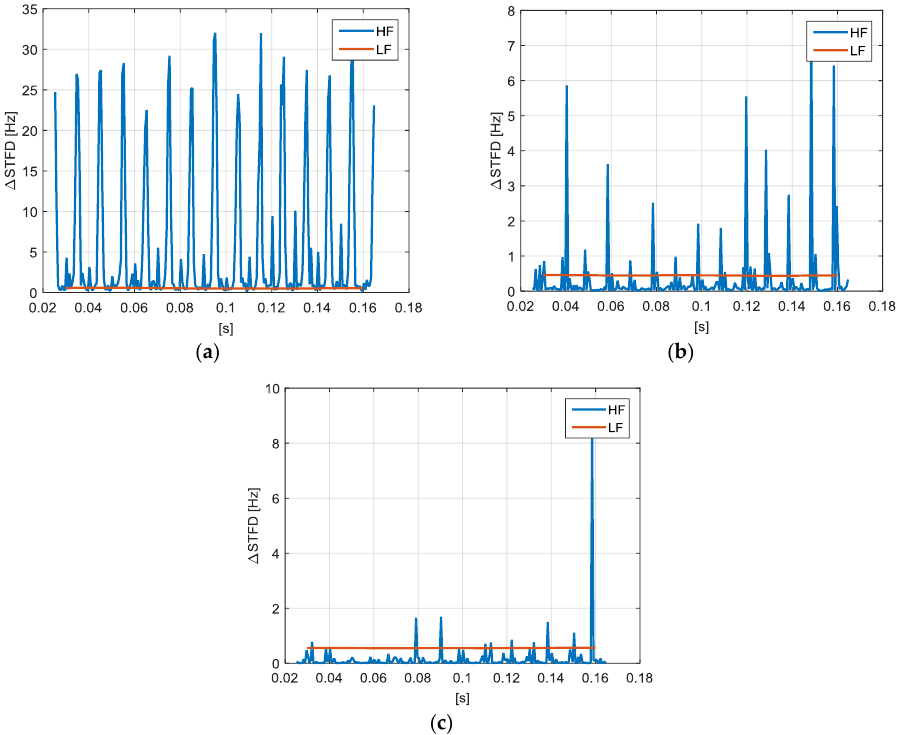
Figure 49. Case study 4: Δ STFD at low-frequency (0 ÷ 2 kHz, red line) and at high-frequency (2 ÷ 150 kHz, blue line) obtained for ( a ) one lamp, ( b ) ten lamps and ( c ) forty-eight lamps.